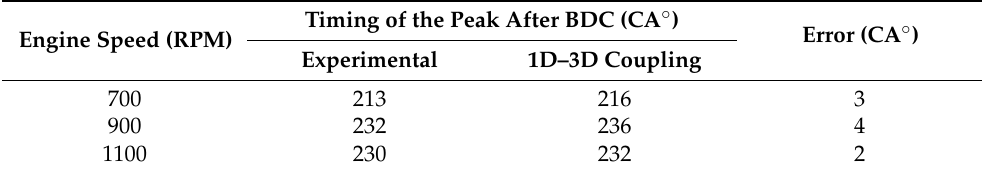
Table 3. Timing of the peak after BDC according to the engine